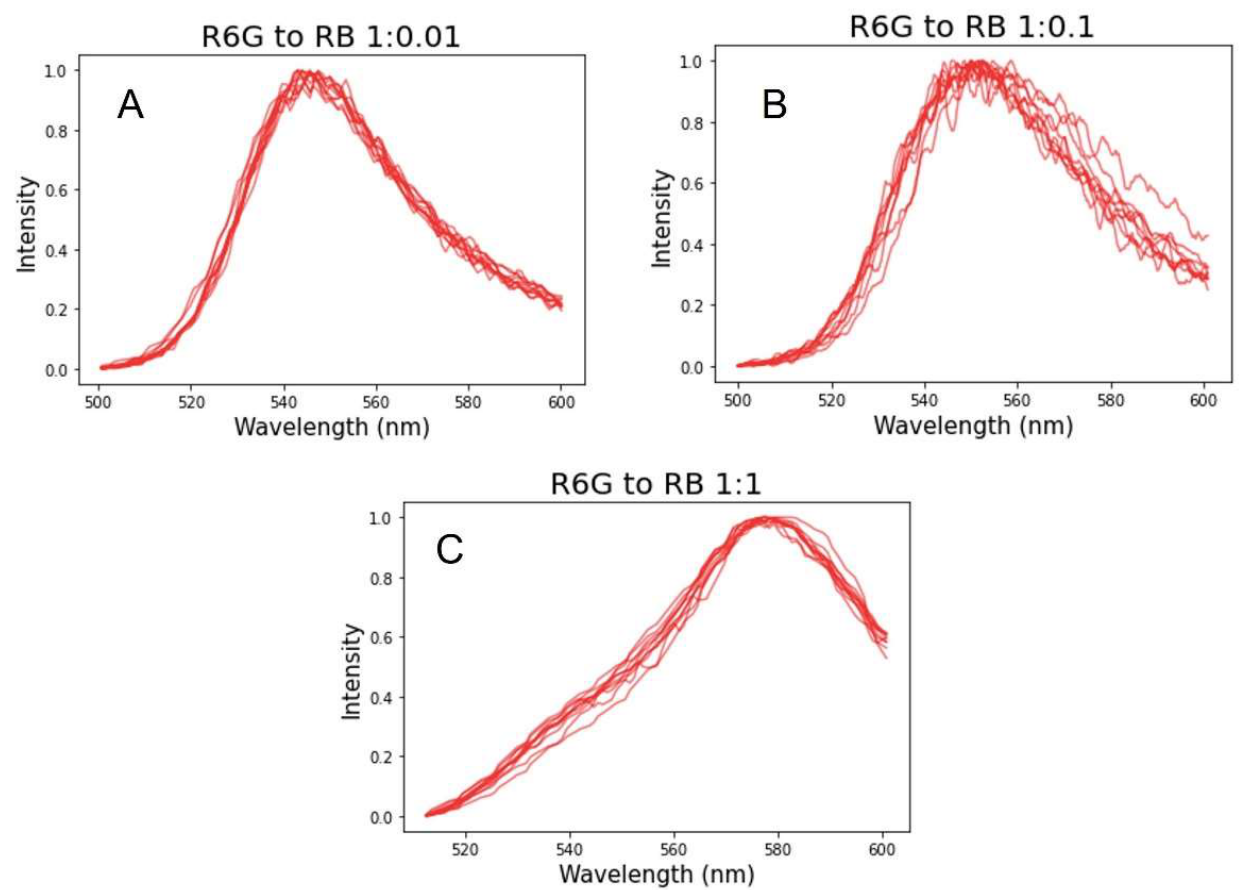
Figure 3. Fluorescence spectra of synthesized SiNPs with R6G to RB ratios of ( A ) 1:0.01, ( B ) 1:0.1, and ( C ) 1:1. All spectra are normalized to have their maxima at 1.